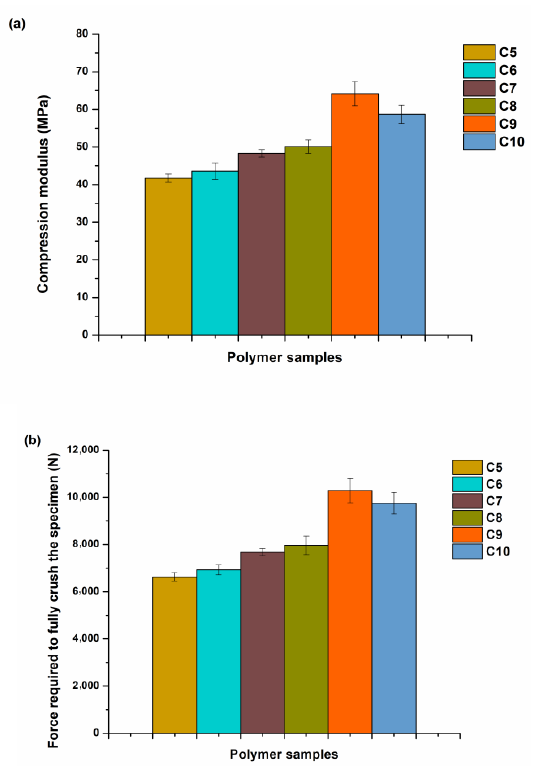
Figure 10. Compression characteristics of photopolymers C5 – C10. ( a ) compression modulus, ( b ) force required to fully crush the specimen.